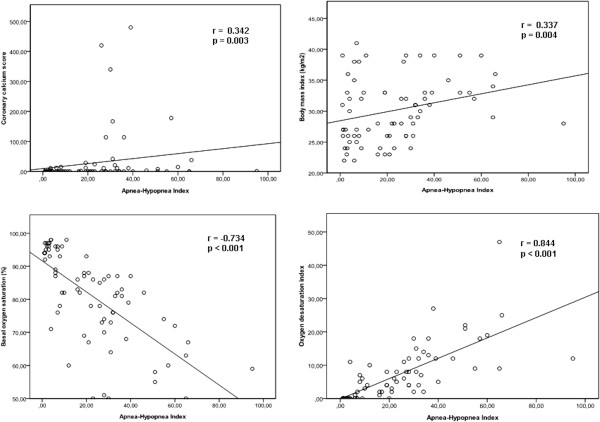
Correlation coefficients for apnea-hypopnea index.